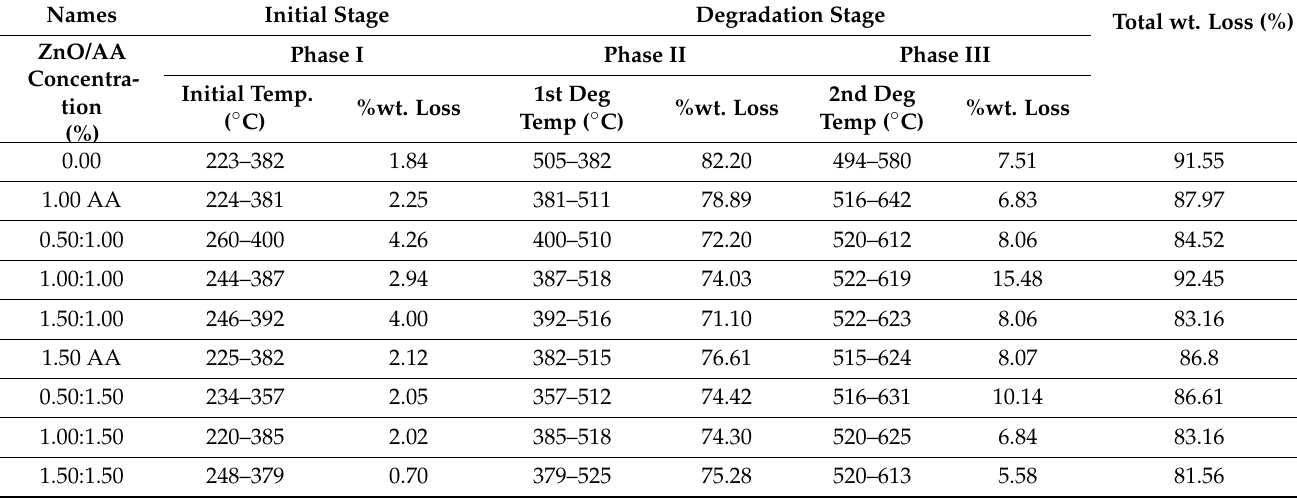
Table 3. Summary of the percentage weight loss phases and decomposition stages of the